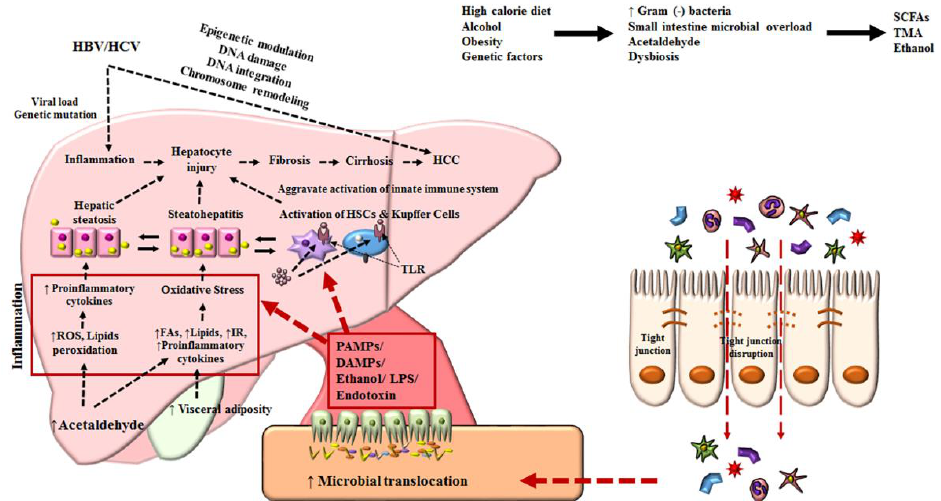
Figure 1. Mechanisms associated with the pathophysiology of hepatocellular carcinoma. Diet, alcohol, obesity, and genetic factors lead to prominent changes in microbiota which induce intestinal bacterial overgrowth, dysbiosis, intestinal permeability, bacterial translocation, and endotoxemia, resulting in the development of HCC. HCC, hepatocellular carcinoma; HBV, hepatitis B virus; HCV, hepatitis C virus; HSC, hepatic stellate cell; ROS, reactive oxygen species; TLR, Toll-like receptor; IR, insulin resistance; LPS, lipopolysaccharide; TNF, tumor necrosis factor; SCFA, short-chain fatty acid; DAMPs, damage-associated molecular patterns; PAMPs, pathogen-associated molecular patterns; TMA, trimethylamine.